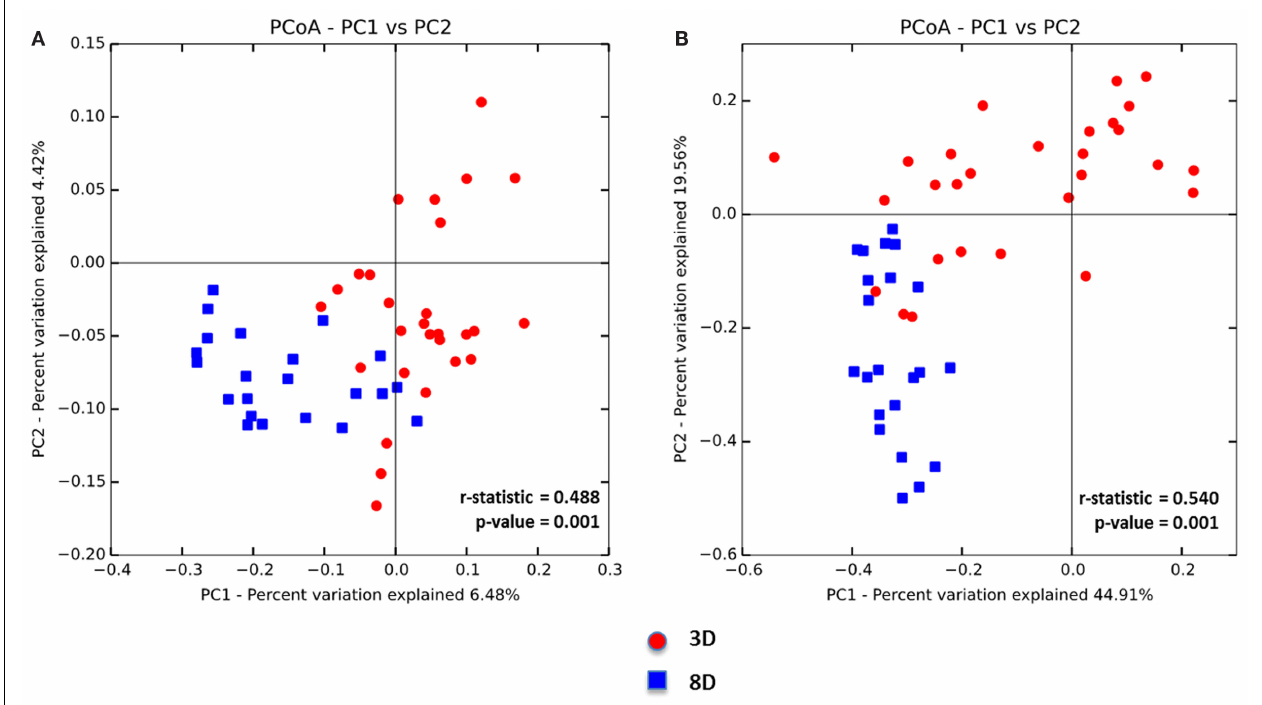
FIGURE 2 | Principal coordinate analysis (PCoA) based on (A) unweighted and (B) weighted UniFrac distances was analyzed for two age groups of non-infected chicks . ANOISM with 999 permutations was used to detect the statistical significant difference between microbial communities of different groups, where both r and p value is reported. Abbreviations: 3D, 3days old; 8D, 8days